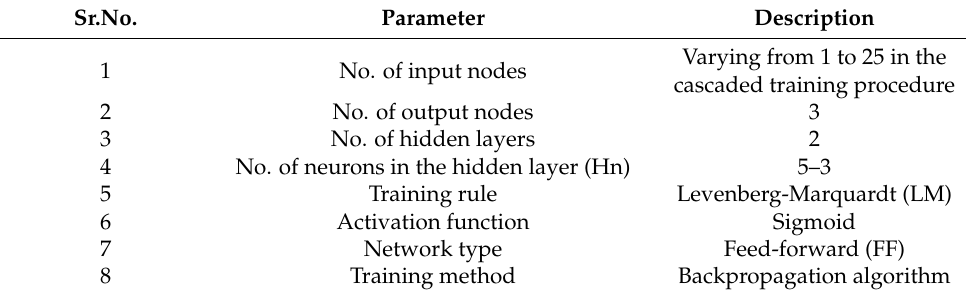
Table 6. Optimum ANN parameters for the design of the model.